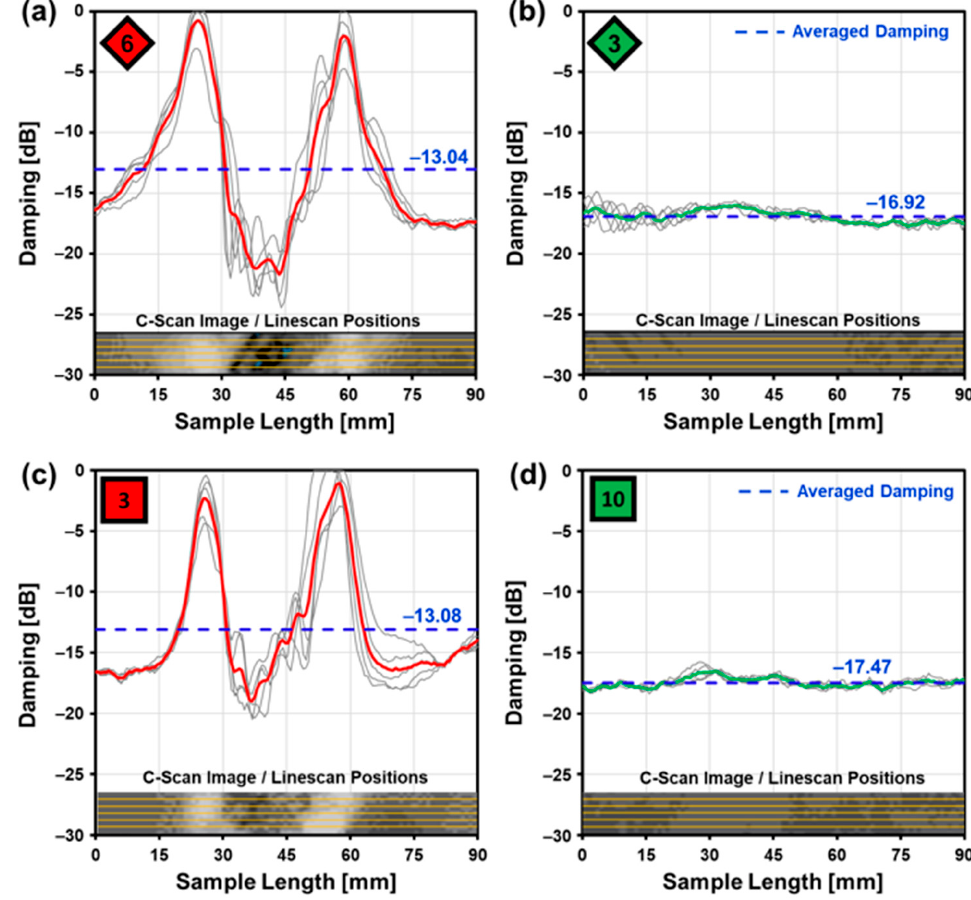
Figure 7. Damping curves extracted from the ACU raw data using the Python-based script. Inset displays the sample C-scan with linescan positions (yellow lines). Damping curves are shown as grey lines in the diagram and in averaged form as red/green line. The dashed line shows the average value over the entire sample length. Samples with fiber orientation ±45° (upper row) and 0/90° (lower row) from inhomogeneous ( a , c ) and homogenous region ( b , d ) of the c-scan.